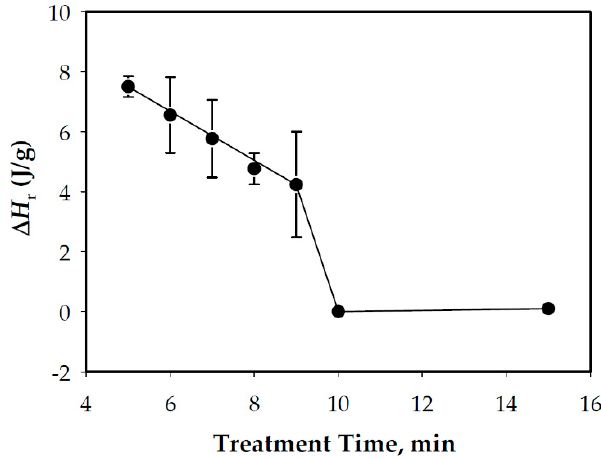
Figure 7. Gelatinization progression as indicated by the disappearance of residual enthalpy, ∆ H r , at the 85 °C treatment temperature.